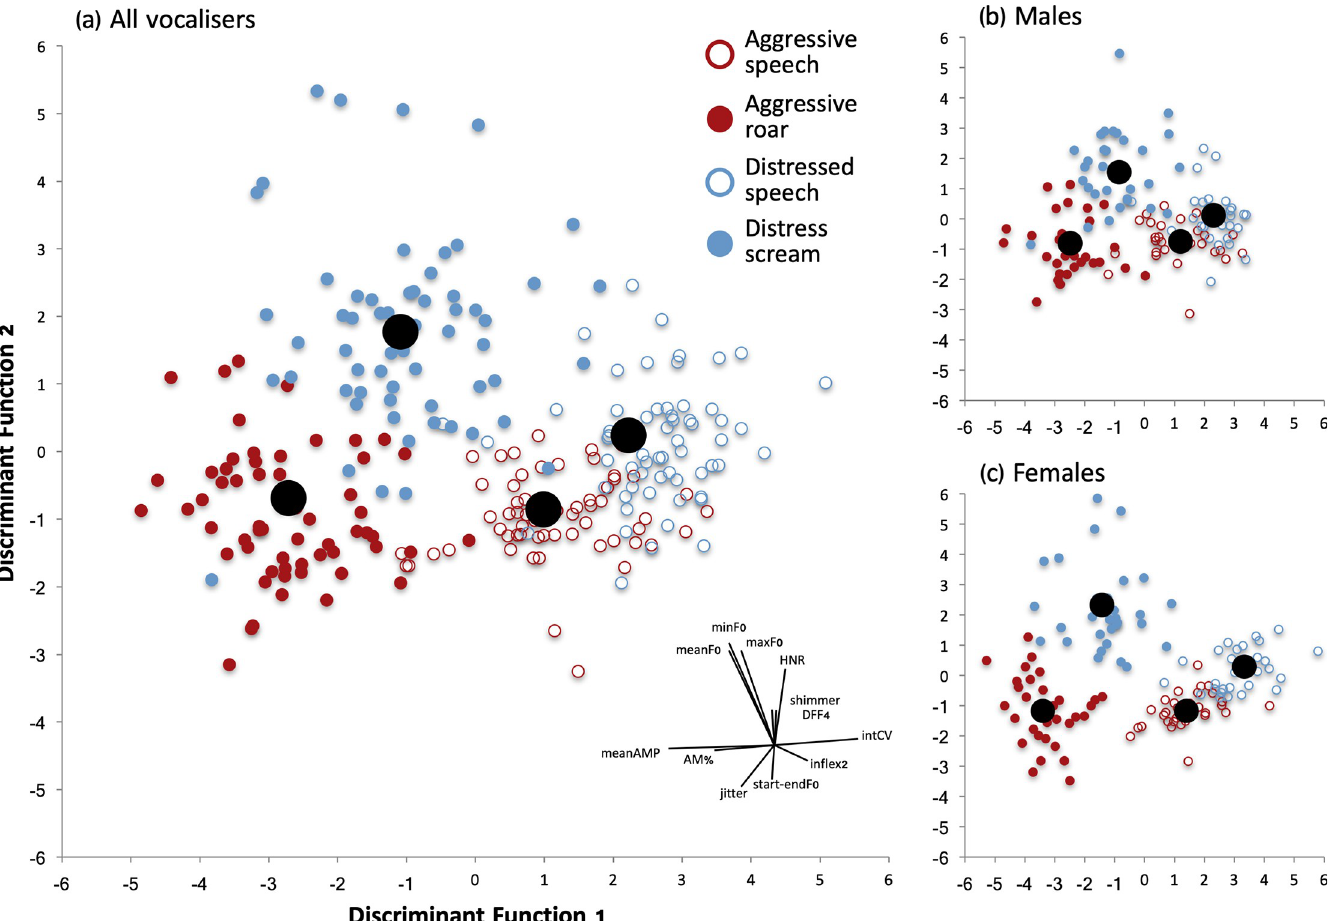
Fig 2. Discriminant function analysis illustrating acoustic separation of voice conditions, (a) for all vocalizers, (b) for male vocalizers only, and (c) for female vocalizers only. Each data point represents the centroid of a vocal stimulus as a function of the first two discriminant variables that maximize individual separation. Larger black circles represent mean group centroids for each voice condition. The radar plot on the bottom right of panel (a) represents the loadings of the acoustic variables on the first two discriminant functions. Mean amplitude, amplitude variability, and amplitude modulation were the main factors separating voice conditions on the first function (DF1, Table A in S1 Tables). The second function (DF2, Table A in S1 Tables) relied mostly on F0 and harmonics-to-noise ratio. The pattern of separation was similar in male (b) and female (c) vocalizers.